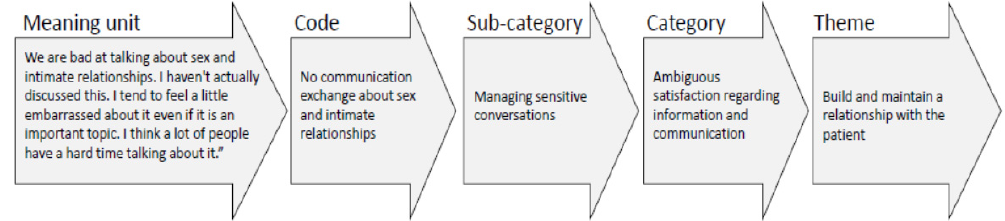
Figure 1. Example of the analysis process, from meaning units to theme.